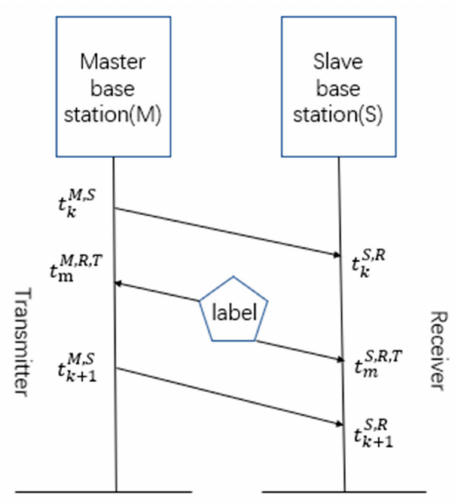
Figure 1. Schematic diagram of the synchronization package.